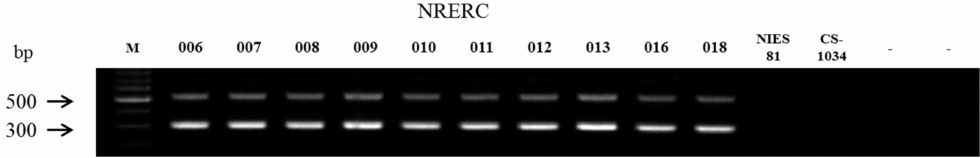
Figure 3. Gel electrophoresis image of ITS PCR products from Aphanizomenon flos-aquae NRERC–006 to NRERC–018, Aphanizomenon gracile strain NIES81, and Chrysosporum ovalisporum strain CS-1034. Upper bands show 541 bp ITS (type-2) PCR products and lower bands show 312 bp ITS (type-1) PCR products. M indicates SiZer-100 DNA marker.